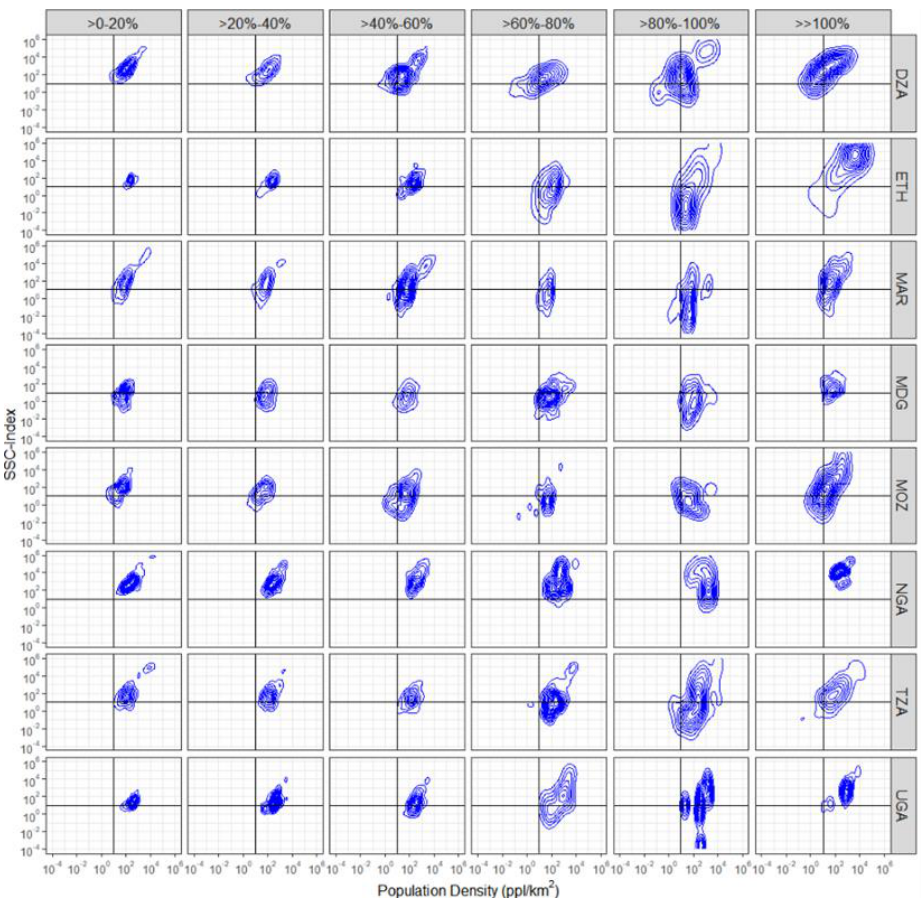
Figure 8. Two-dimensional-density plots showing the relationship among the population density, the Settlement Size Complexity Index (SSC-Index), and the REE at different ranges of the